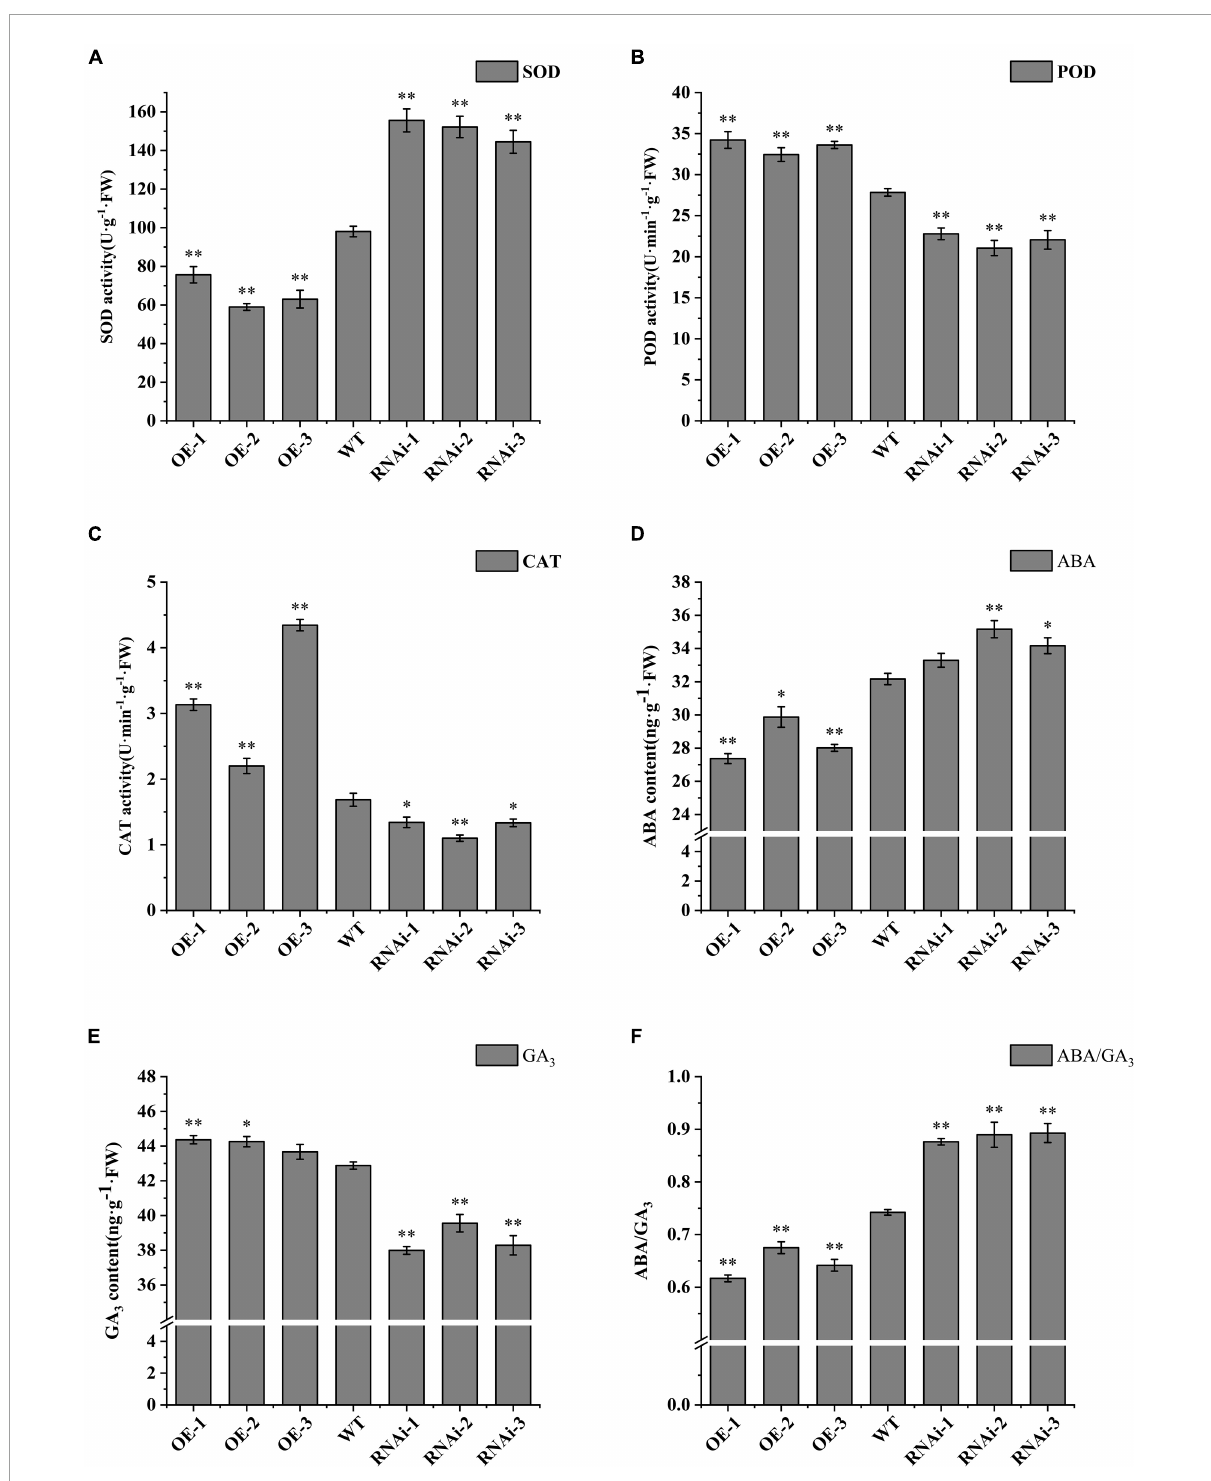
FIGURE5 Antioxidant-related enzyme activity and endogenous hormone ABA/GA3 in tubers released from dormancy. (A) SOD activity; (B) POD activity; (C) CAT activity; (D) ABA content; (E) GA3 content; (F) ABA/GA3 ratio. WT: Wild-type tubers of “Desiree”; OE-1 ∼ OE-4, Transgenic tubers of “Desiree” carrying recombinant plasmids pBI121-StTCP15; RNAi-1 RNAi-4, Transgenic tubers of "Desiree" carrying recombinant plasmids pCPB121-amiR-StTCP15. Each column represents the mean values SE ( n =3; ∗ P < 0.05; ∗∗ P <